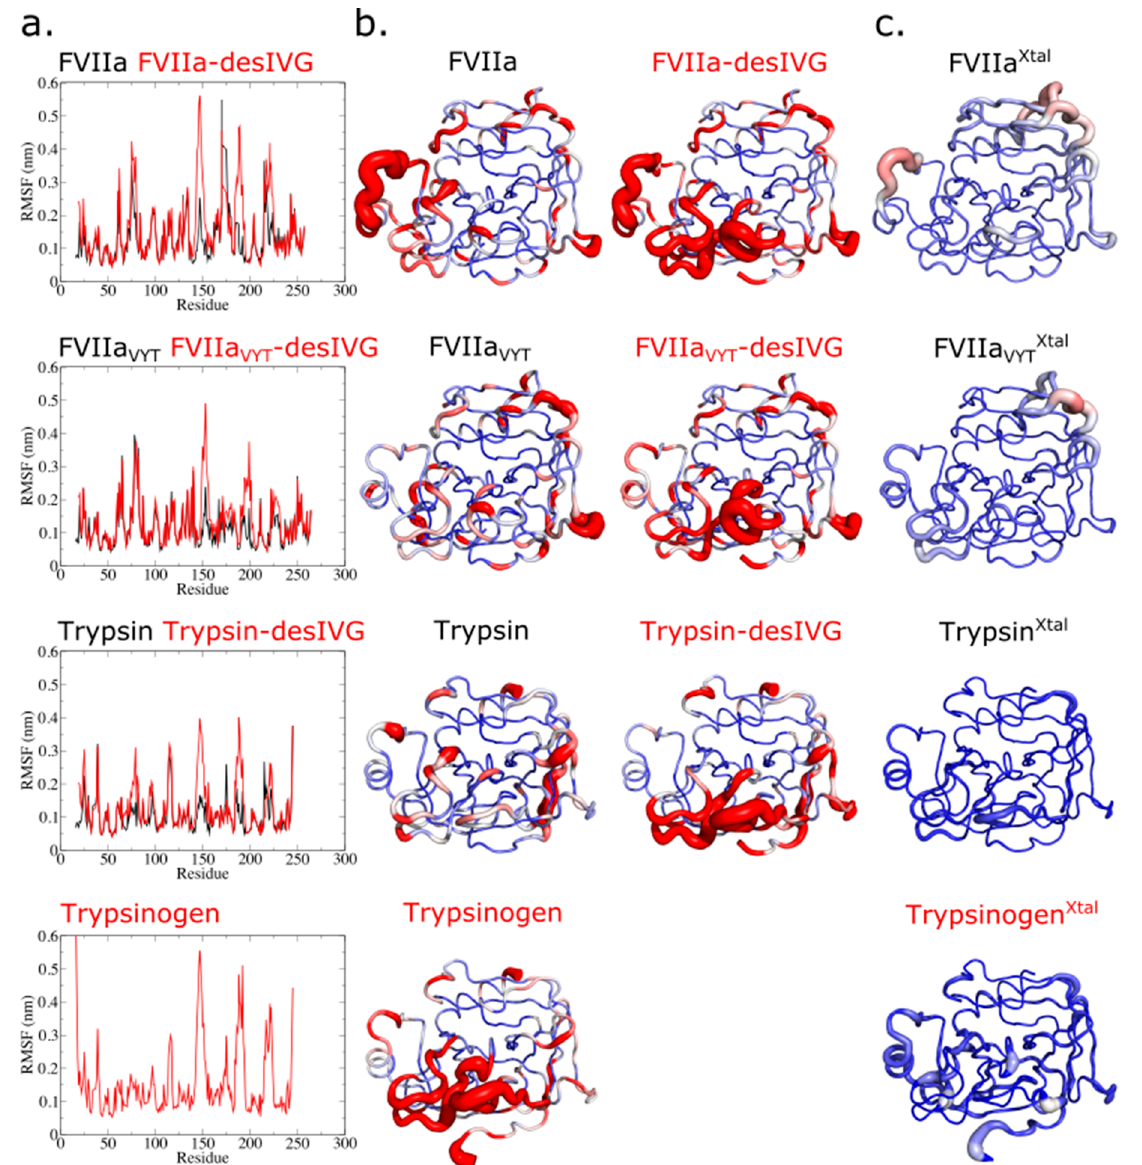
Figure 2. ( a ) Per-residue root-mean-square fluctuation (RMSF) of the simulated constructs. ( b ) Visualization of the B factors based on the computed RMSF values. Proteins are shown using a “sausage” cartoon representation where the thickness of the tube indicates the B-factor. The color scale goes from low (blue) over medium (white) to high (red). ( c ) Visualization of the crystallographic B-factors. Proteins are shown using a “sausage” cartoon representation where the thickness of the tube indicates the B-factor. The color scale goes from blue (low) over white (medium) to red (high). Structure PDB IDs are indicated in Table 1.